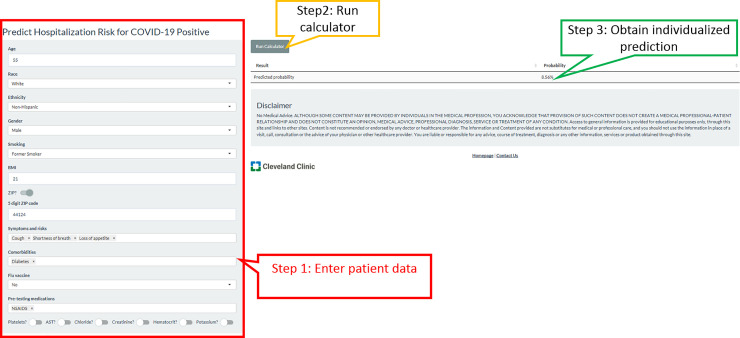
Online risk calculator for risk of hospitalization from COVID-19, found at https://riskcalc.org/COVID19Hospitalization/.The example here is a 55-year-old white male, former smoker, who presented with cough, shortness of breath, and loss of appetite. He has diabetes and received no vaccinations this year and is only on NSAIDs for some chronic joint pains. No labs are available yet. His predicted risk of hospitalization is 8.56%. If race is changed to Black, with all other variables remaining constant, his relative risk almost doubles to an absolute value of 17.22%.